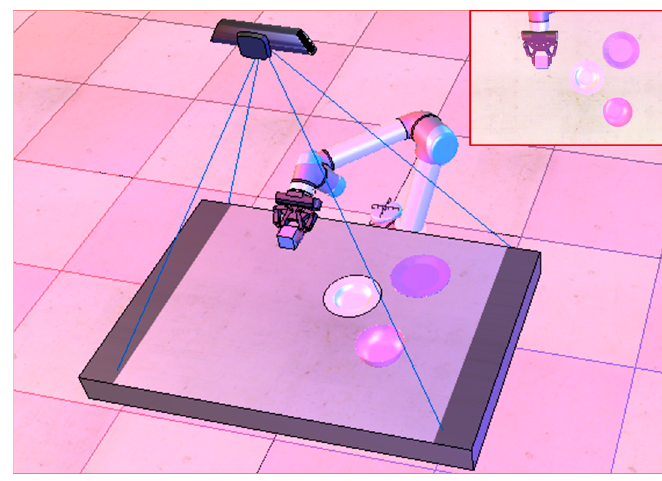
Figure 9. New environment in the testing phase.